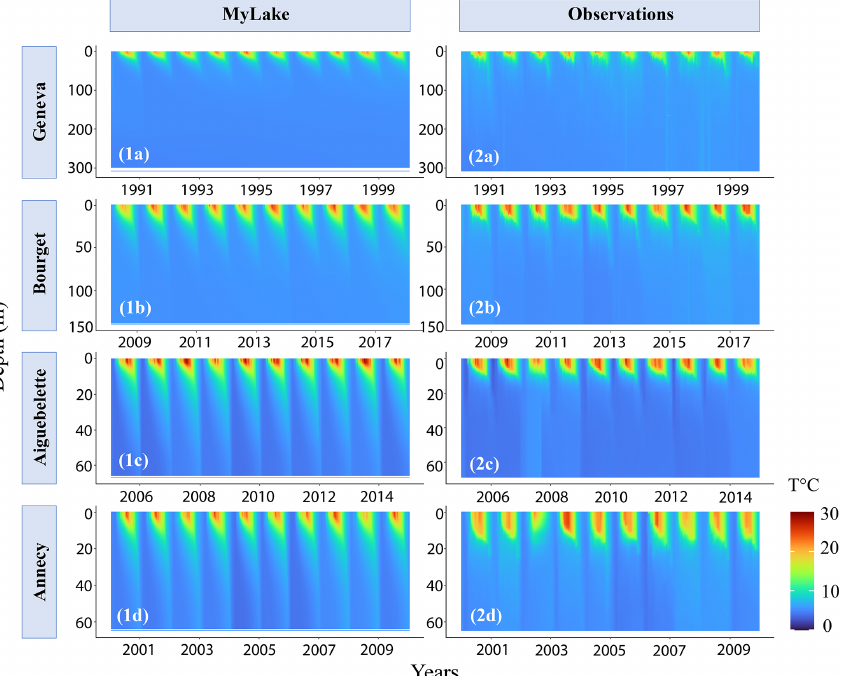
Figure 3. Daily averaged MyLake water temperature simulations (1) and interpolated observations from the OLA database (2) in Lake Geneva (a) , Bourget (b) , Aiguebelette (c) , and Annecy (d) over the 10-year validation period.